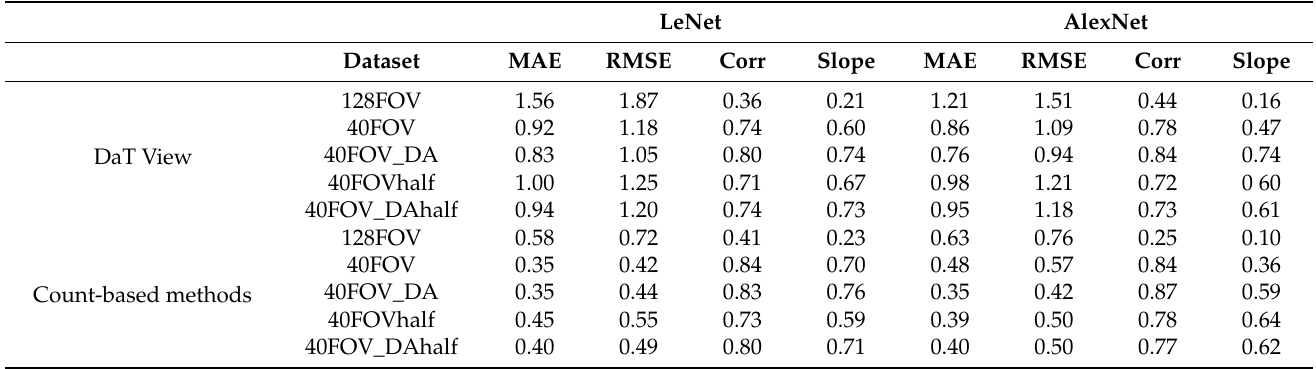
Table 2. Results of DaT View and count-based methods analysis. MAE, RSMU, Corr, and